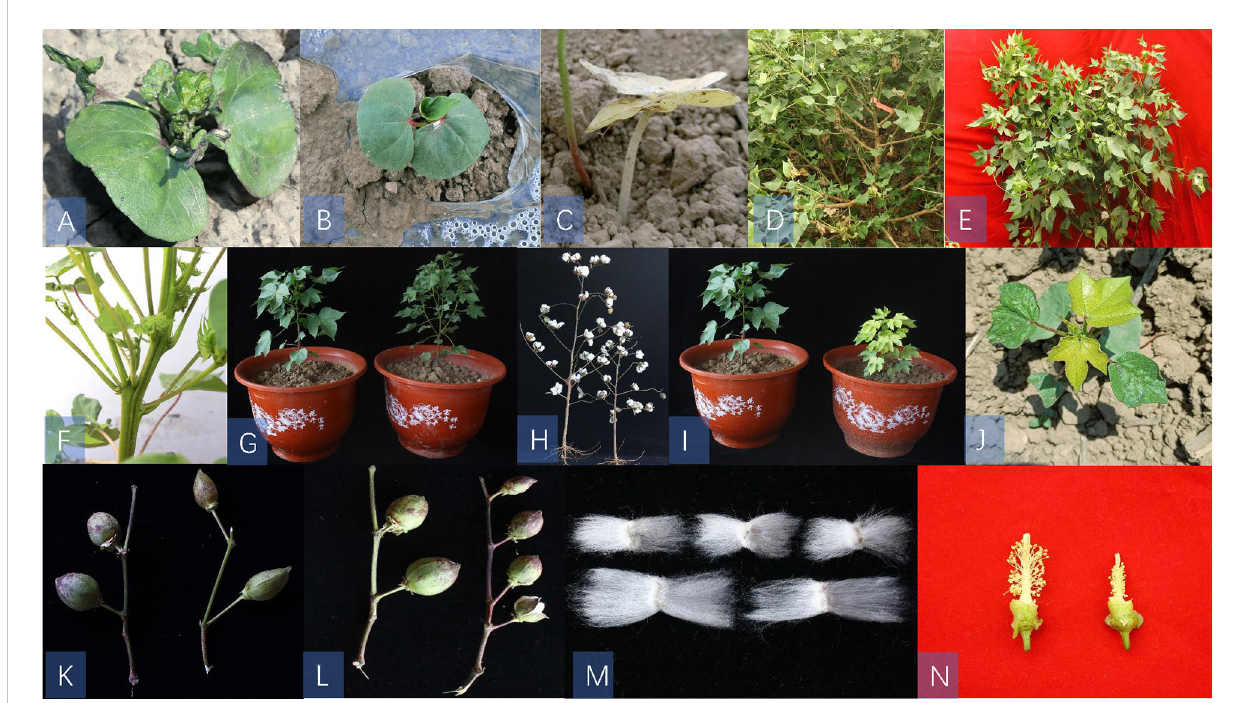
FIGURE 1 Phenotypic mutants in M2 populations. Panels (A-C) : lethal mutants; panels (D, E) :sterility mutants; panels (F-H) : plant architecture mutants; panels (I, J) : leaf color mutants, panels (K, L) : boll stalk and boll shape mutants, (M); fi bre mutant and (N); fl ower style mutant. panels (G, H, I, K, L, N) : WT is on the left and mutants is on the right; (M); mutants is below and WT is